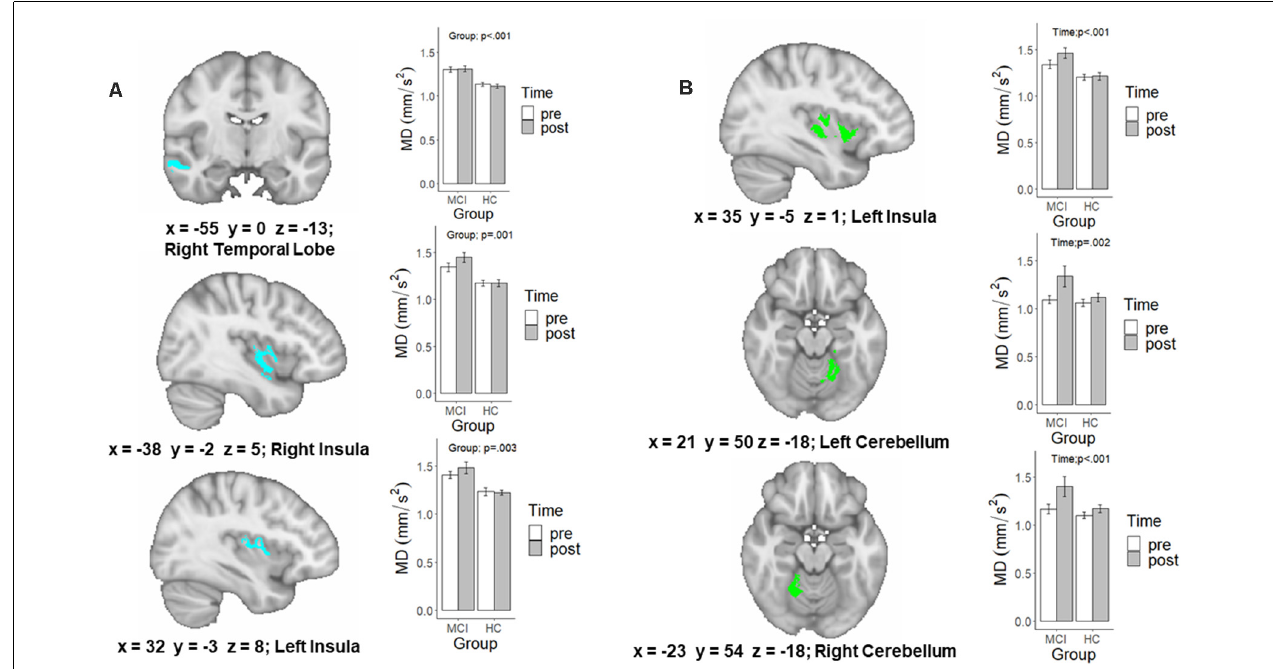
FIGURE 2 | A map of the significant family-wise error (FWE) and age-corrected voxel-wise analysis of the (A) main effect of Group and (B) main effect of Time. Extracted values in the bar graph are raw diffusion values and not adjusted for age. p-values are the result of running these raw diffusion values through a similar linear mixed effects model, in which age was controlled